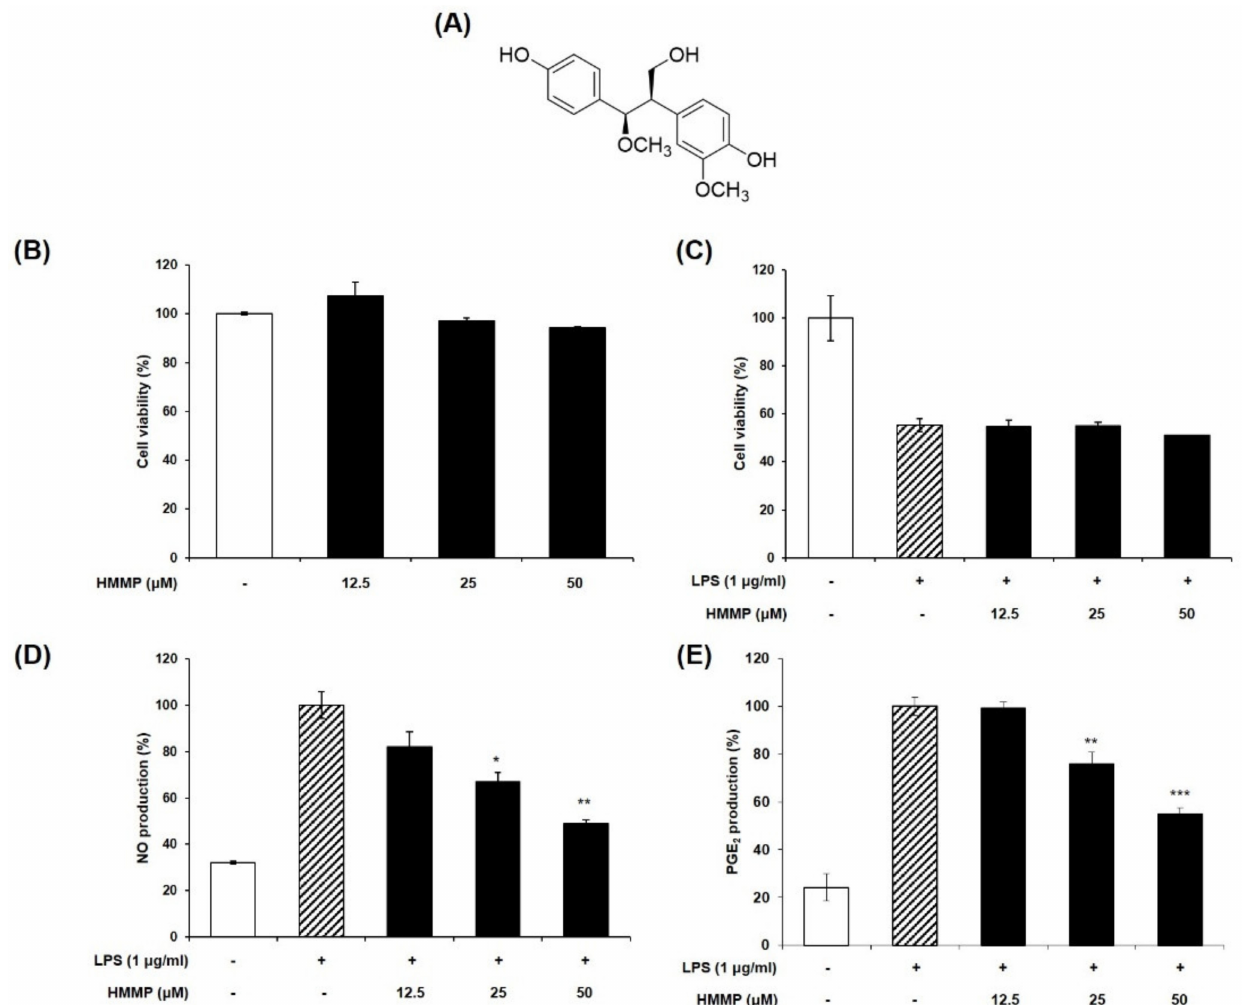
Figure 1. ( A ) Chemical structure of HHMP, ( B , C ) cell viability in presence or absence of LPS, ( D , E ) effect of HHMP on LPS-induced NO and PGE 2 production in RAW 264.7 cells. Cells were pre-treated with HHMP (12.5, 25, and 50 µ M) and then treated with LPS for 24 h. NO production was measured using Griess reagent and PGE 2 production was analyzed using an ELISA kit. Cell viability was assessed with an MTT assay. +: added in the cells; -: not added in the cells. All experiments were performed in triplicate, and the results are expressed as the mean ± standard deviation (SD); * p < 0.05, ** p < 0.01, *** p < 0.001, and **** p < 0.0001 compared with the LPS-stimulated